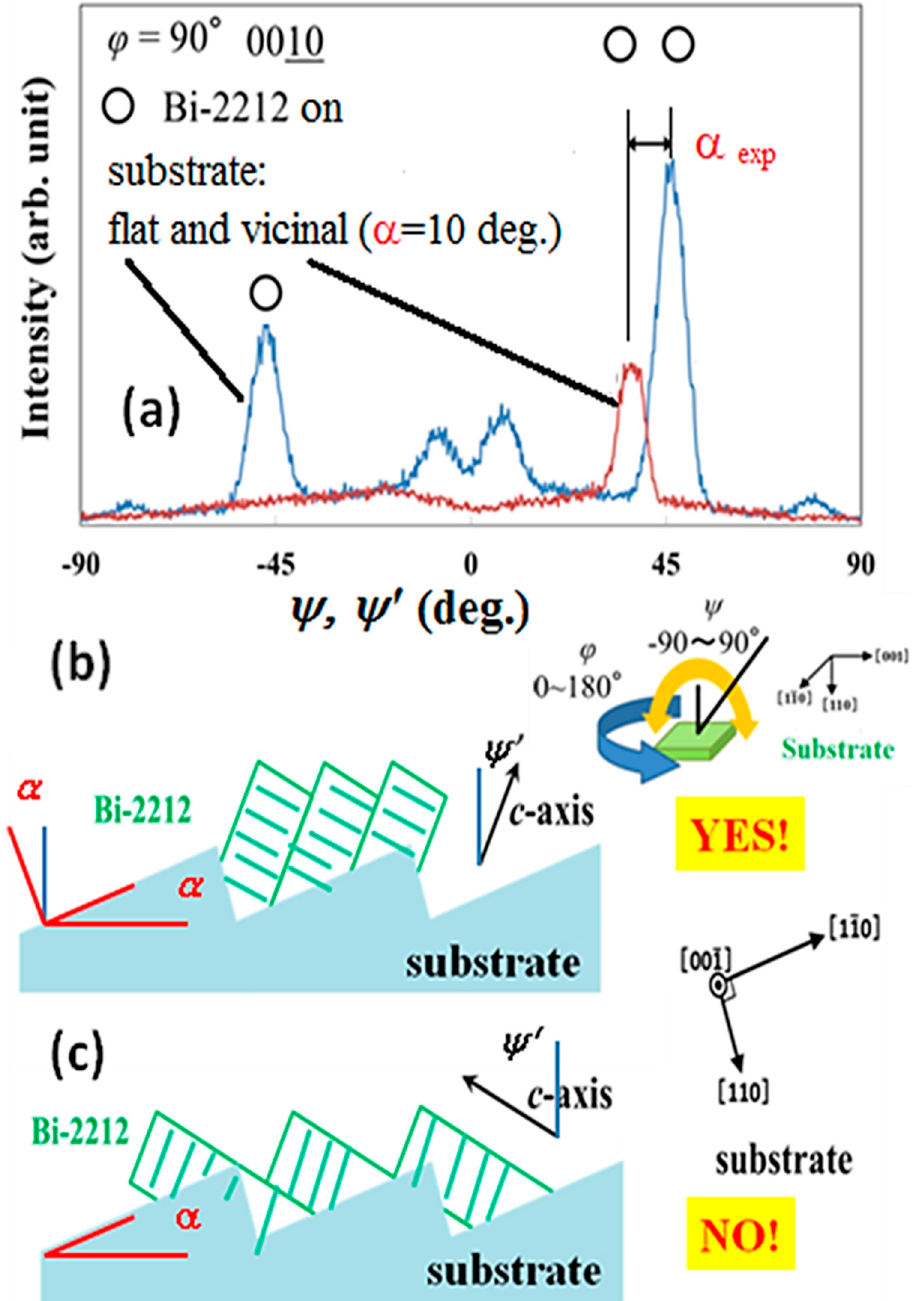
Figure 7. ( a ) XRD ψ and ψ ’ scans for constant ϕ = 90 ◦ of the (0010) plane (2 θ = 29.048 ◦ ) on the non c -axis Bi-2212 thin films grown on flat and vicinal (off angle 10 ◦ ) STO substrates, respectively; ( b , c ) Theoretical models for the step-flow growth mechanism that promotes twin-free growth. Results indicate that growth of the non c -axis Bi-2212 thin film takes place according to model from ( b ). Inset to ( b ) shows a schematic drawing of the ϕ - ψ measurement arrangement for the film grown on a flat substrate.